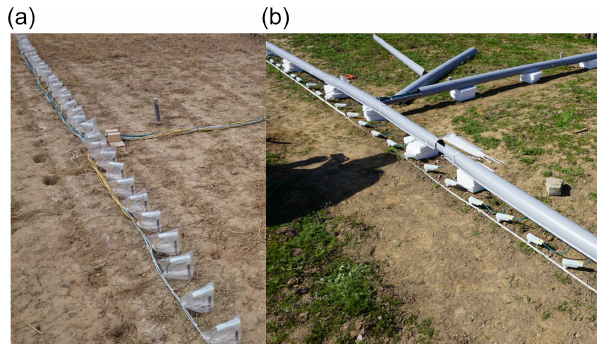
Figure 4. Installation of electrodes, electrode modules and connect- ing cables. (a) Installation in 2017. (b) Installation in